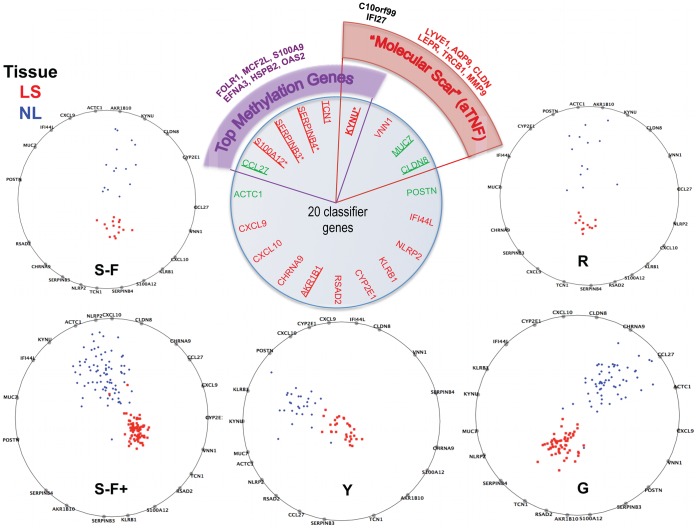
MAD classifier.Radviz plots showing how the 20 genes selected by MTGDR procedure separate the lesional (LS) and non-lesional (NL) samples apart in each study. Perfect separation between LS and NL samples can be seen in every study. S-F+: Suarez-Farinas 2012, hgu33plus2 chips; G: Gudhjonsson’2009; S-F: Suarez-Farinas’2010; R: Reischl’2007; Y: Yao’2008. Center insert shows biological relevance of these genes. Top 25 psoriasis genes in Table 1 are underline. 6 of these 20 genes have been identified as top methylation genes discriminating between psoriasis (LS) and healthy skin. 4/20 were identified as part of the Residual Disease Genomic Profile (RGDP) or “Molecular Scar”.